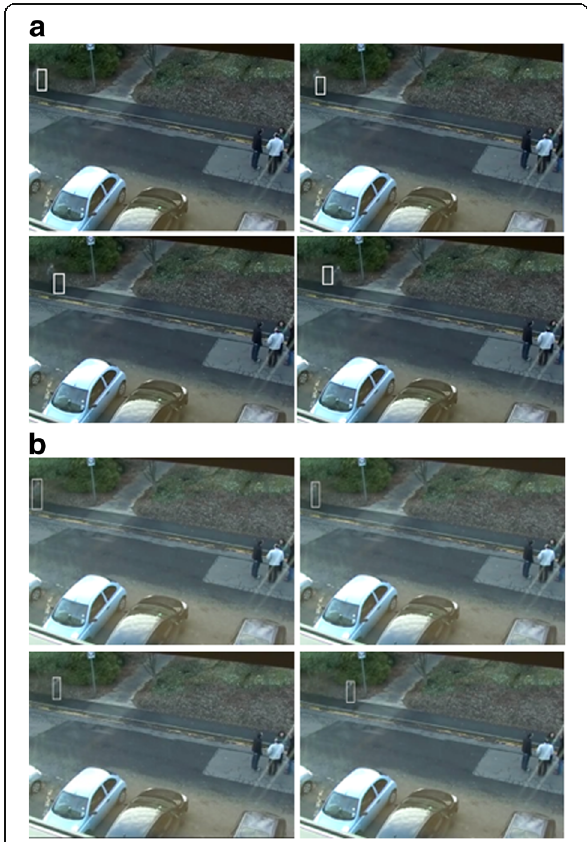
Fig. 15 Results of person tracking from CAVIAR database set, ( a ) mean-shift algorithm, ( b ) proposed method (images are from left to right and top to down)